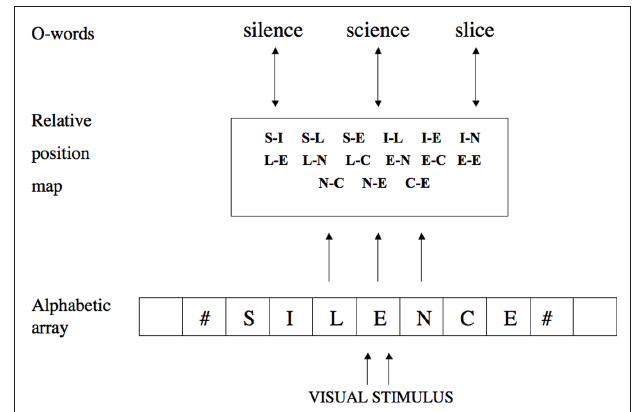
Figure 1 | grainger and van Heuven’s (2003) model of orthographic processing. Visual features activate location-specific alphabetic character detectors (the alphabetic array) aligned along the horizontal meridian. Next, information from the alphabetic array is mapped onto ordered pairs of contiguous and non-contiguous letters (not all possible combinations are shown). Finally, relative-position-coded letter identities activate whole-word orthographic